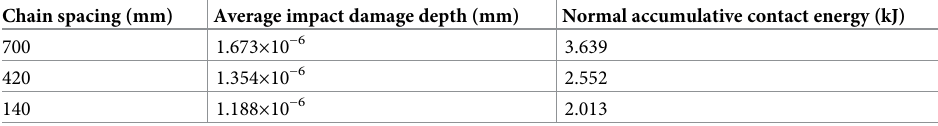
Fig 11. Normal accumulative contact energy curve of the middle trough under the different chain spacings. https://doi.org/10.1371/journal.pone.0266831.g011 Table 8. Simulation results of the impact damage under the different chain